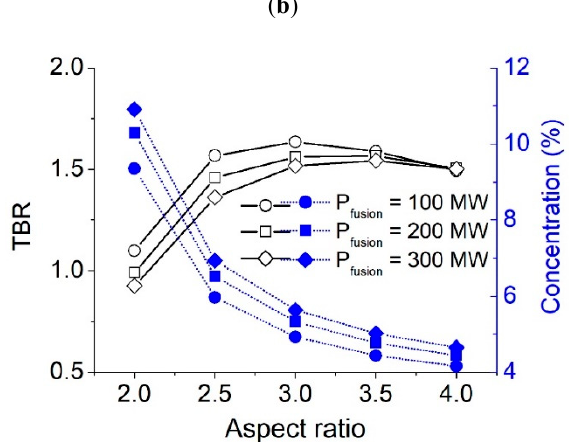
Figure 3. The impacts of the aspect ratio on ( a ) the minimum R 0 and the neutron wall loading; ( b ) initial TBR and initial TRU concentration for FLiNaBe.